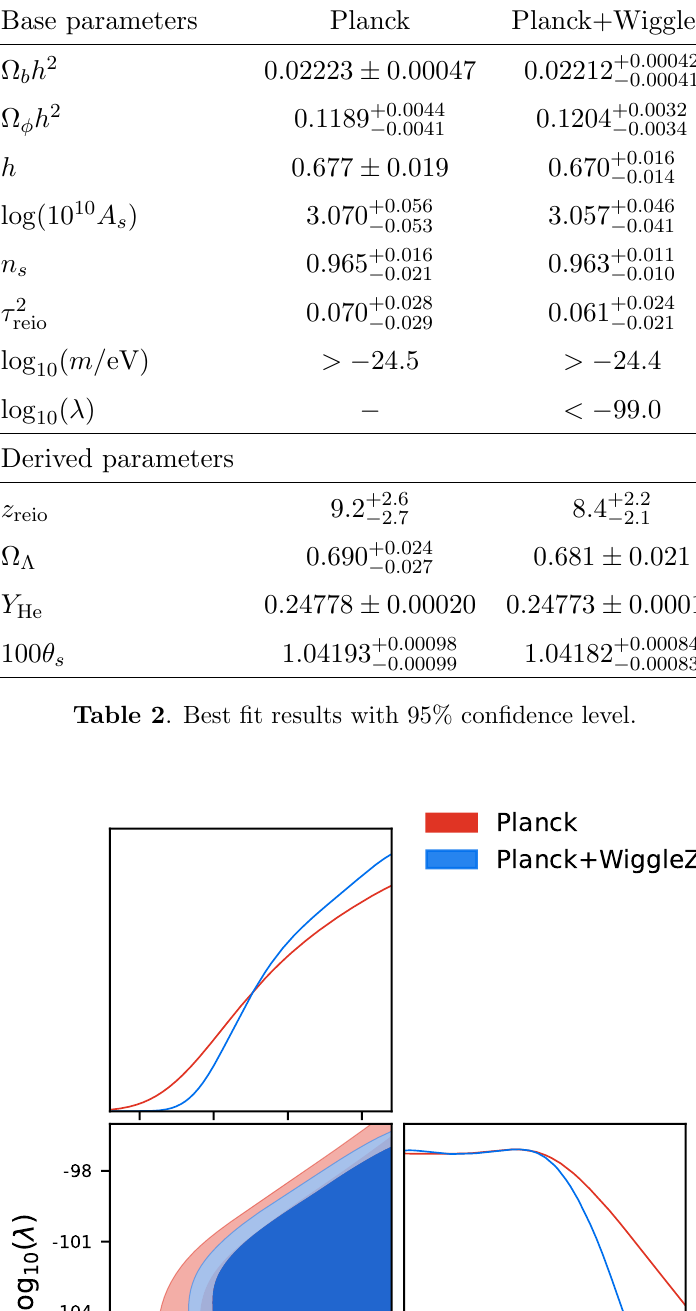
Figure 7 . Contour plots with 95% and 99% con(cid:12)dence levels and 1d marginalized distributions.